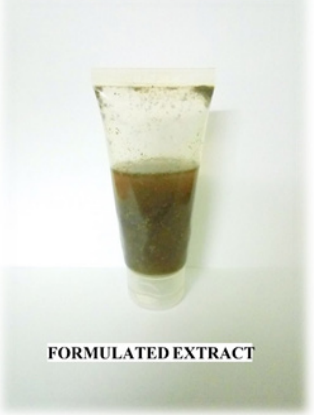
the extracts. Fig. 2. Formulated extract containing 1:1:1:1 ratio